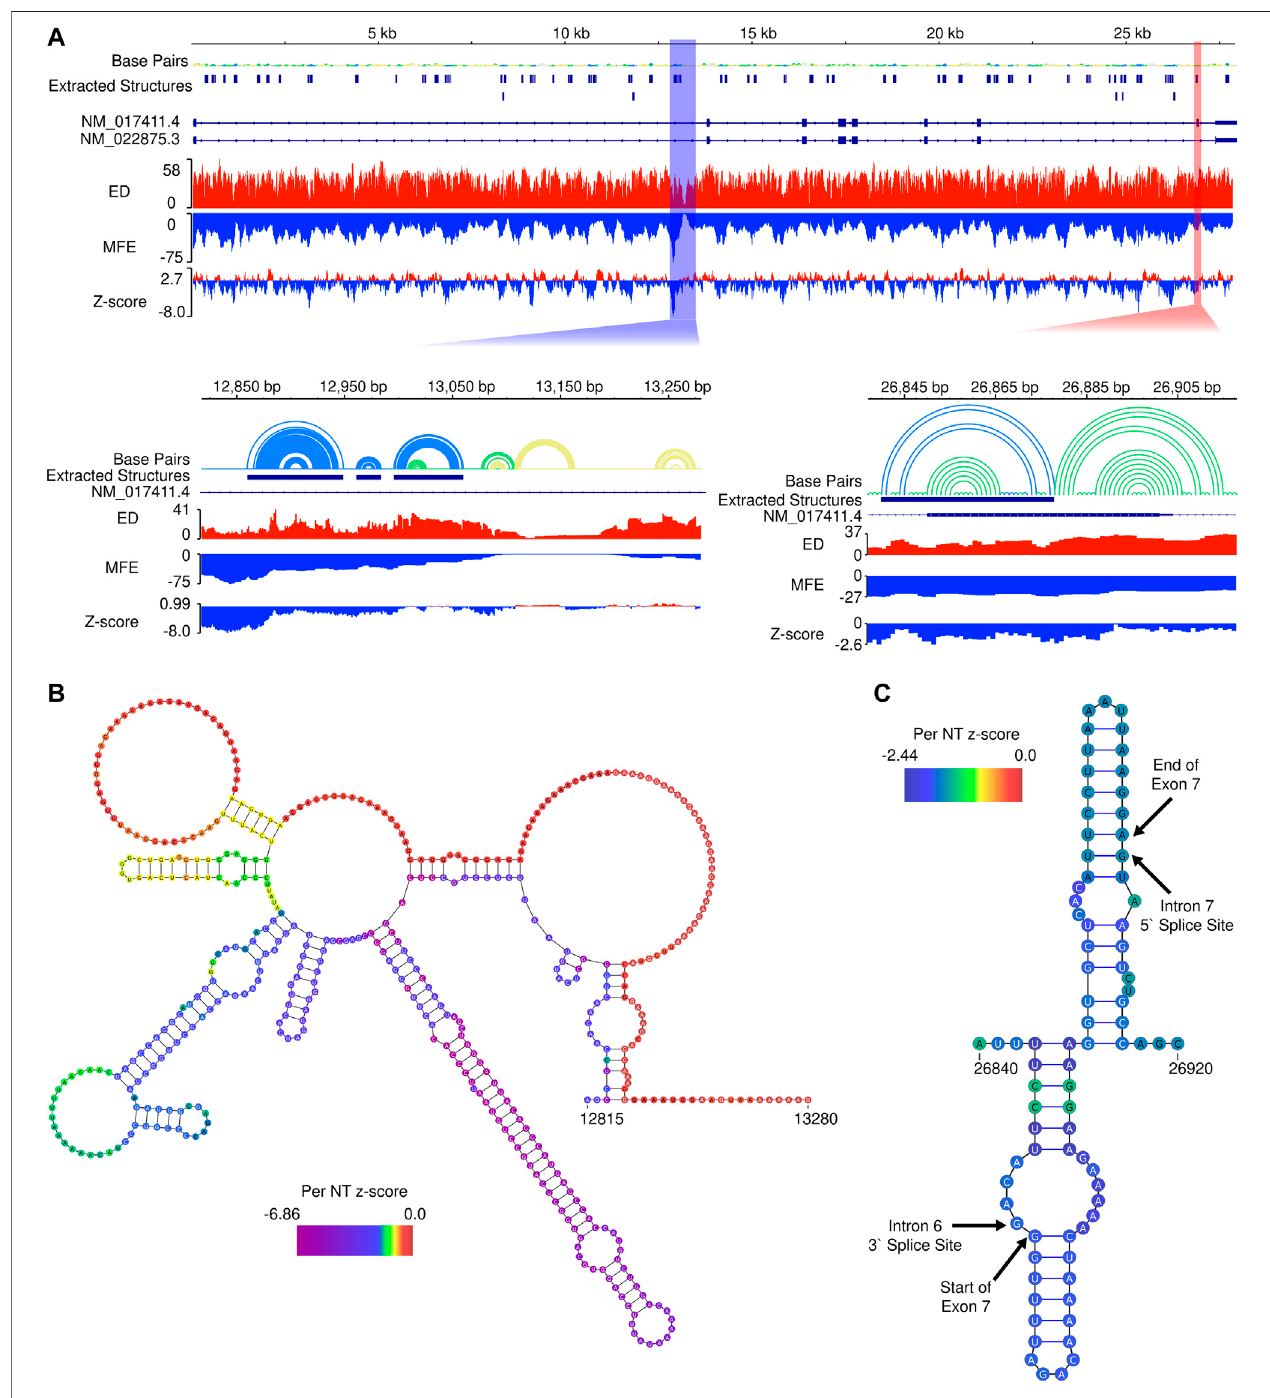
FIGURE5| Insilico ScanFoldresultsforthepre-mRNAof SMN2 . (A). Atthetop,anIGVrepresentationofthewhole SMN2 pre-mRNAtranscriptwith6datatracks: a base pair (arc diagram) track, a track showing ScanFold extracted structures where base pairs with z-score < -2, -1 and 0 are indicated in blue, green and yellow, respectively; a track of transcripts (with introns as lines and exons as boxes), an ensemble diversity (ED) track, a minimum free energy (MFE) track, and a Δ G z-score track. Below the whole transcript are two zoomed in regions. Highlighted by the blue box is a region of SMN2 with the lowest z-score and both the lowest and highest MFE regions in the transcript. Highlighted by the red box is Exon 7, which contains one of the two extracted structures present in an exonic region. (B). The ScanFoldinformed2DmodelofthebluehighlightedregionfrompanelAisshownwiththepernucleotide(NT)z-scoreoverlaidonthemodel. (C). TheScanFoldinformed 2D model of the red highlighted region from panel A is shown with the per nucleotide (NT) z-score overlaid on the model. Here, the boundaries of intron splice sites and the start and stop site of exon 7 are labelled.